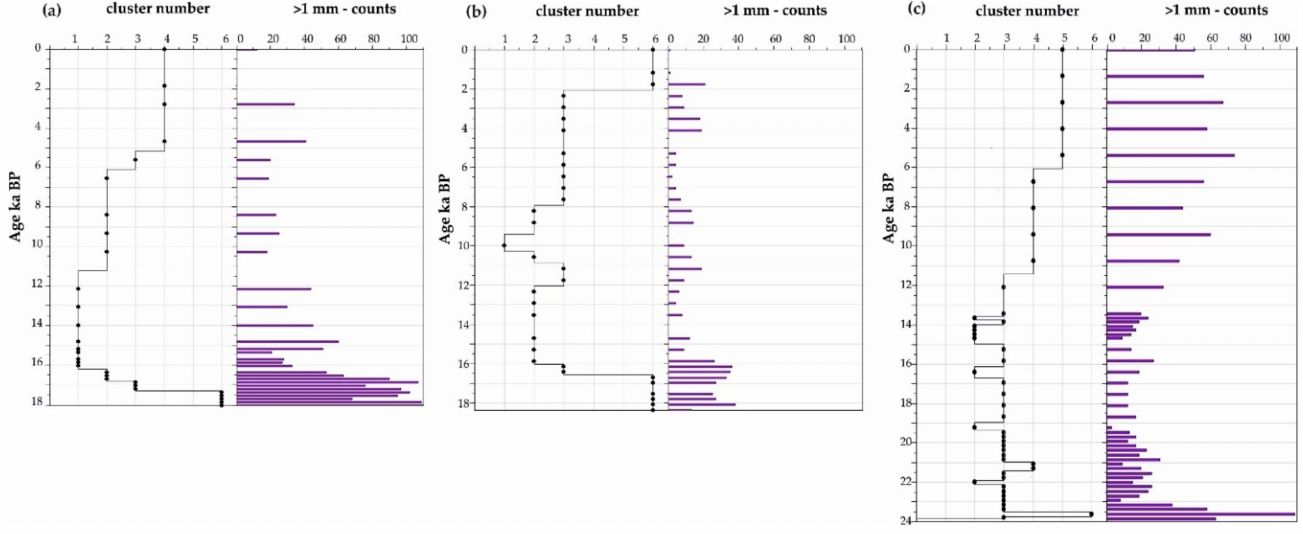
Figure 6. Down-core distribution of the grain size clusters and >1-mm fraction: ( a ) BC02 ( b ) BC03 ( c )